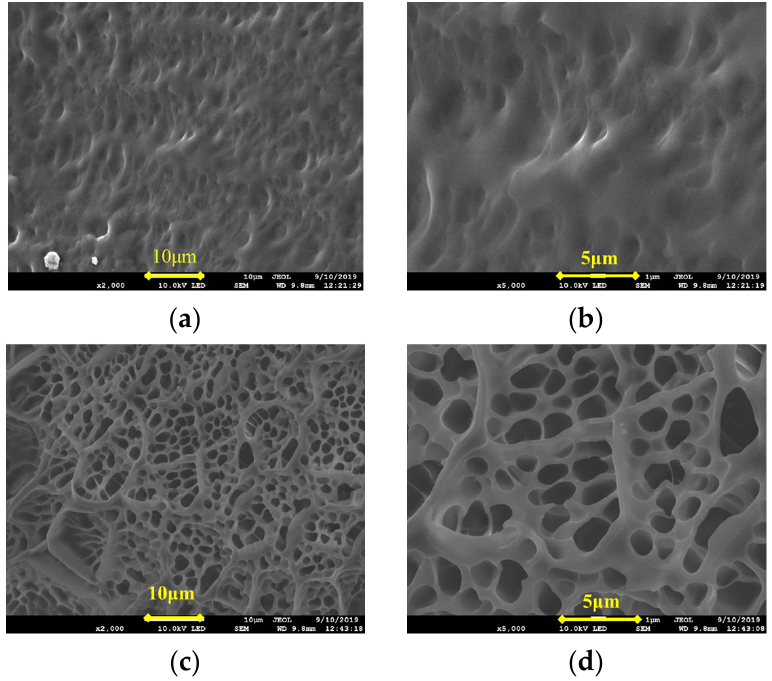
Figure 2. SEM images of the frozen colloids prepared with 1.0% and 3.0% concentrations of the cross-linking agent. ( a ) 1.0%, ×2000; ( b ) 1.0%, ×5000; ( c ) 3.0%, ×2000; and ( d ) 3.0% , ×5000.